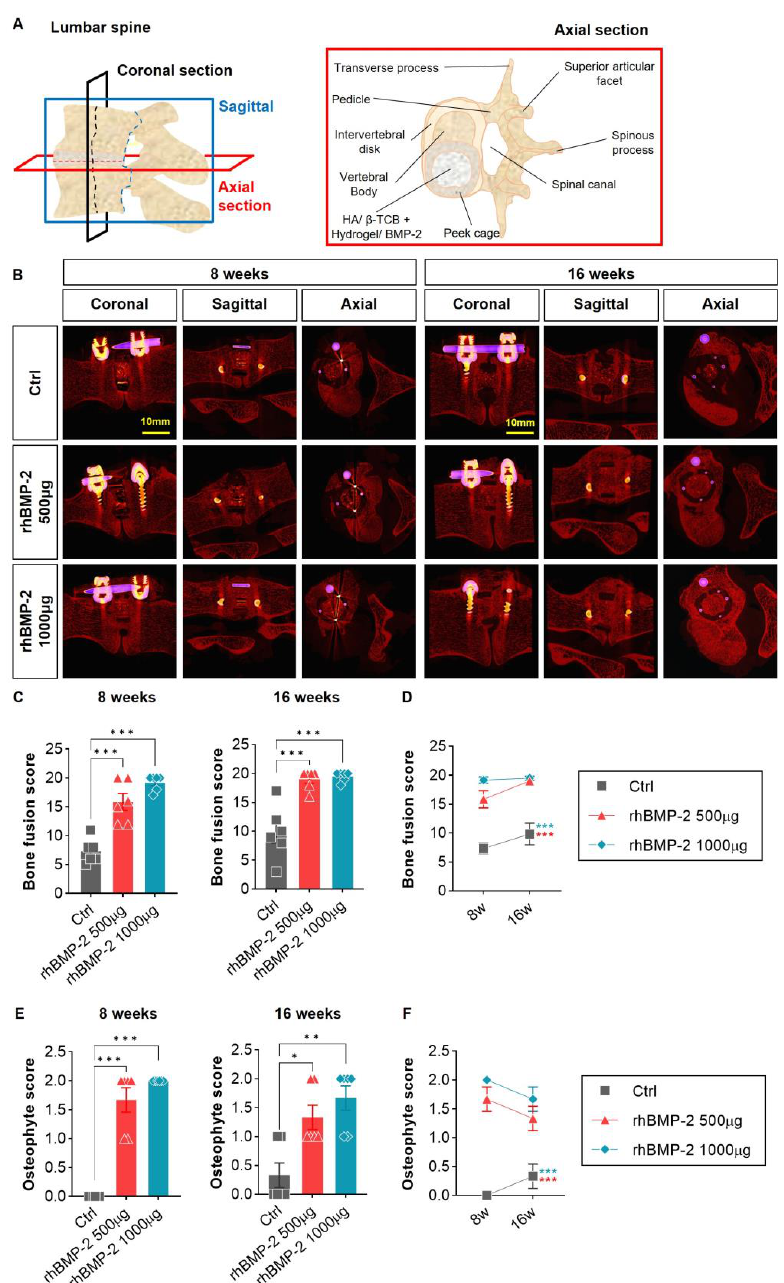
Figure 2. Fusion rate and osteophyte analysis of 2-dimensional sections. ( A ) A schematic image of the lumbar spine and cage implanted axial section. ( B ) Through micro-CT, the fusion rate was analyzed and scored from 0 to 20 points. ( C , D ) A significant difference in fusion was clearly observed between the control (Ctrl) and BMP groups. The BMP group had a higher fusion score. ( E , F ) A significant difference was also found in osteophyte formation, with lower BMP concentrations corresponding to lower scores. * p < 0.05, ** p < 0.01, and *** p < 0.001 indicate statistically significant